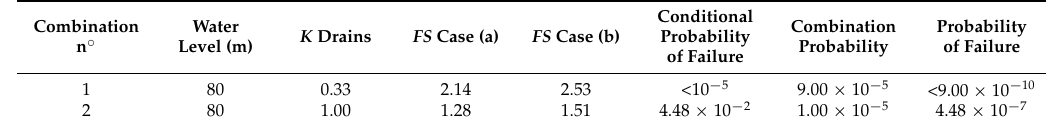
Table 15. Approach III. Results for SOF = 10 m.